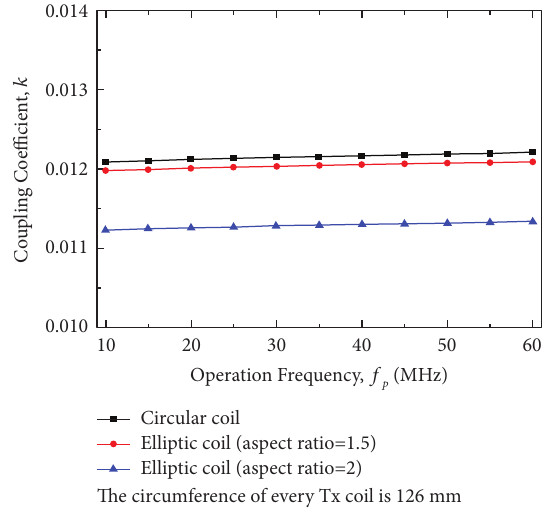
Figure 4: Simulation results of k between one of the three shapes of a single-turn Tx coil and an Rx coil. For the Rx coil, R 2 � 5mm, r 1 � 0.287mm, r 2 � 0.04mm, and n 2 � 1. The distance between the Tx and Rx is